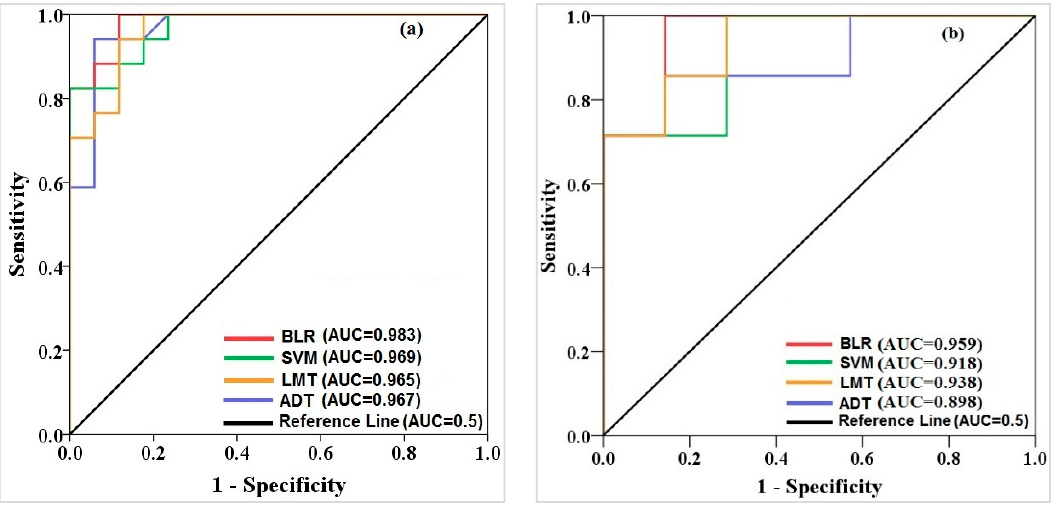
Figure 5. Model validation and comparison using AUROC based on the ( a ) training and ( b ) validation datasets.